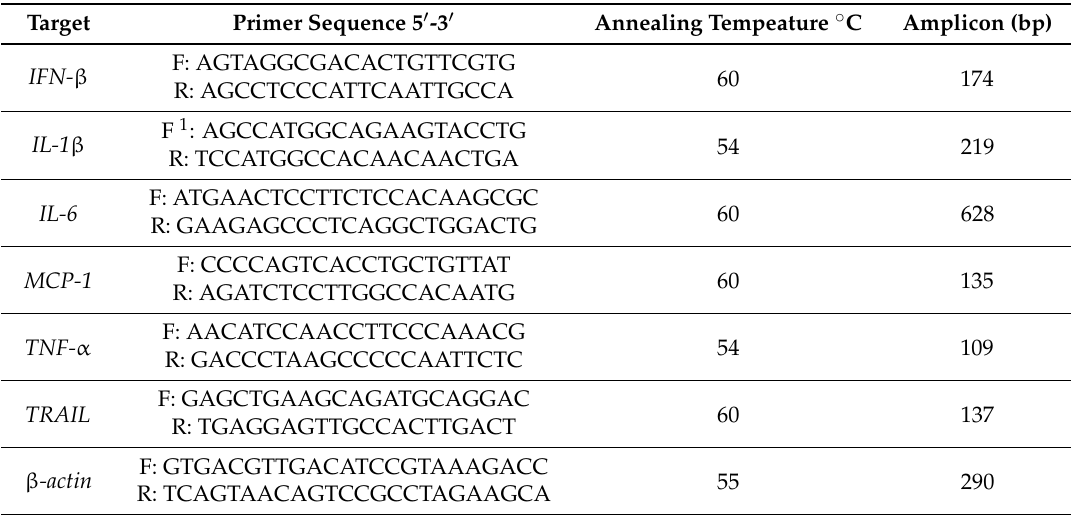
Table 1. Used primer sequences for